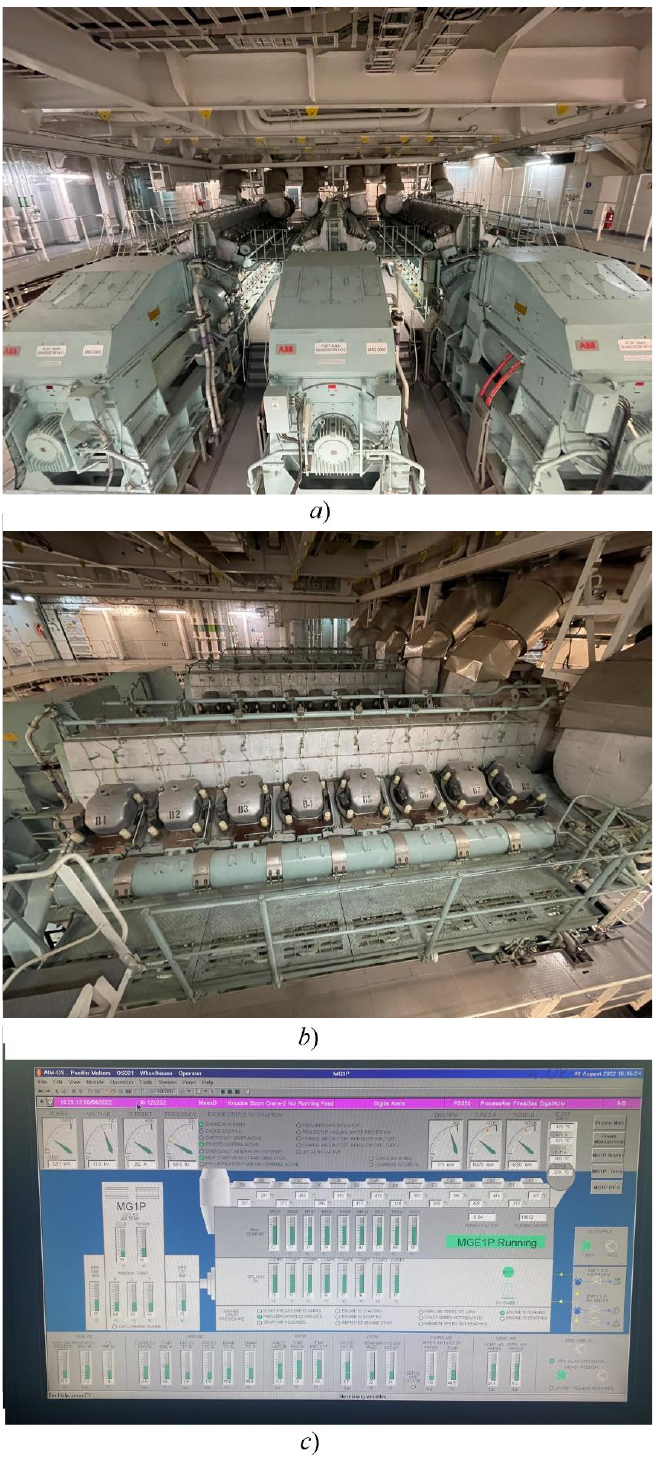
Figure 7. Marine diesel 16V32 STX-MAN: ( a ) location in the engine room; ( b ) general view; ( c ) marine system for monitoring the performance of the diesel engine 16V32 STX-MAN. The measurements were carried out at a fixed fuel supply and stabilization of the heat fluxes of the cooling media (circulating oil, fresh, and seawater).